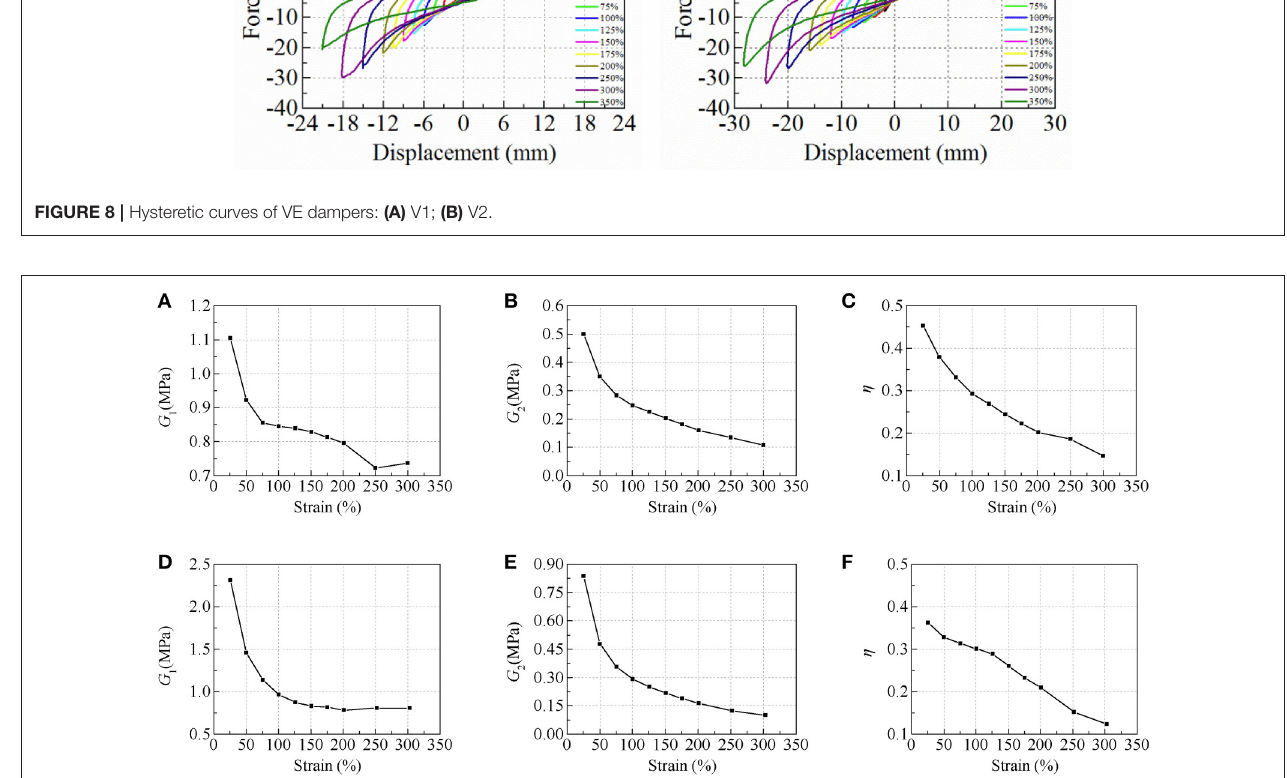
FIGURE 9 | Strain dependency: (A) shear storage modulus of V1; (B) shear loss modulus of V1; (C) loss factor of V1; (D) shear storage modulus of V2; (E) shear loss modulus of V2; (F) loss factor of